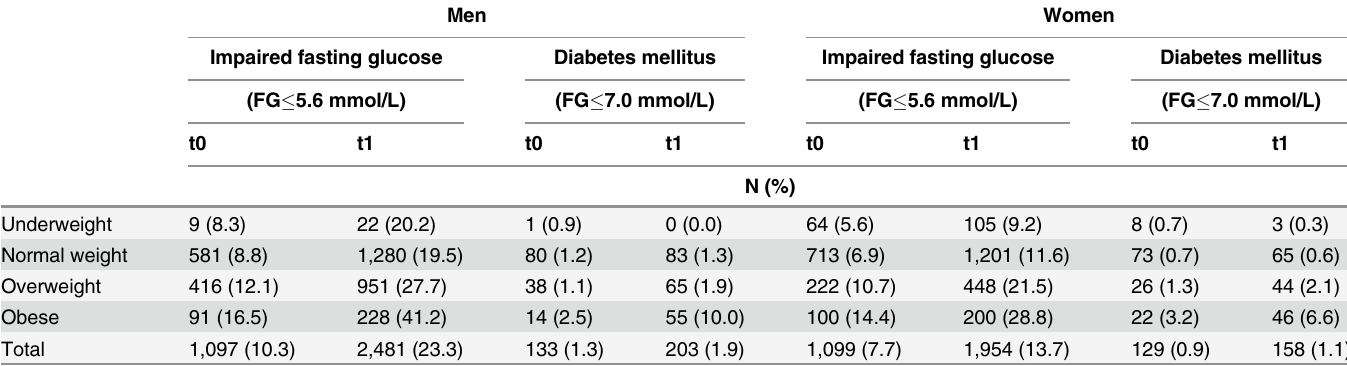
Table 3. Baseline (t0) and 10-year follow-up (t1) prevalence of impaired fasting glucose and diabetes by baseline BMI category.